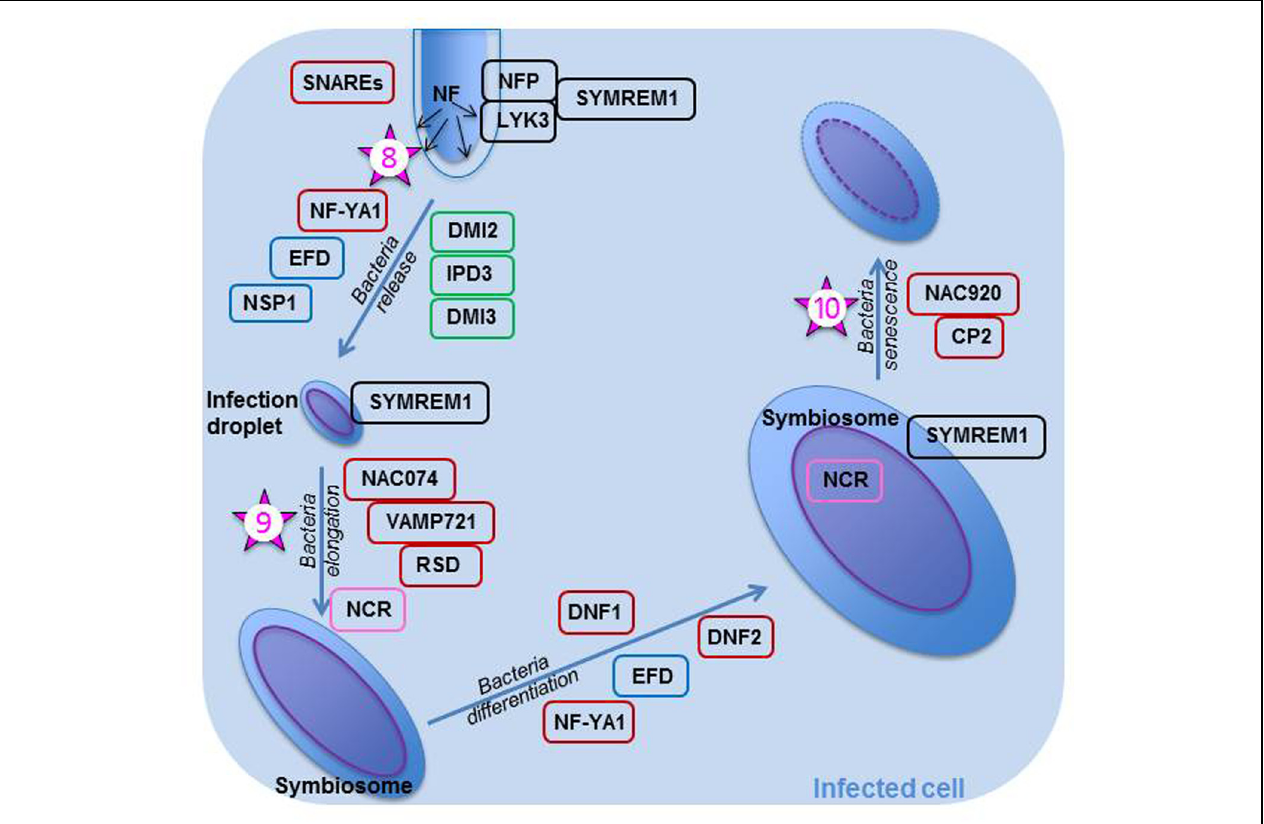
FIGURE 2 | Rhizobial release and bacteroid differentiation within an infected plant cell of Medicago truncatula . Once the rhizobia are released in the infection droplets, they divide and elongate. They later on differentiate into bacteroids; many bacterial genes, such as those necessary for division, are then turned off, whereas genes the products of which are necessary for bacteroid metabolism (nitrogenase, transporters, etc ... ) are turned on. As all these events are important steps in the symbiosis, they are controlled tightly and many genes and their products are implicated in their control. All proteins within a black box are known to be involved with the NF perception. Those in a green box are known to be part of the common symbiotic transduction pathway. Proteins in a blue box are thought to play a role in both the epidermal and cortical nodulation programs. Proteins in a brown box are not known to play a role early in the nodulation process; they may be specific for controlling these specific steps. NFs are continuously produced by rhizobia within the infection thread and when the rhizobia are released, the NFs are perceived by NFP and LYK3, the Nod factor receptors. These receptors are likely to be recruited in a micro-domain by SYMREM1 expressed in the plasmalemma of the infected cell. SNAREs and NF-YA1 are essential in bacterial release, whereas NAC074, VAMP721, and RSD are required for bacterial elongation. The bacteria differentiate once they have perceived the antimicrobial NCRs, which are found in the bacteroid after they crossed both symbiosome and bacterial membranes. DNF1 is necessary for the entry of NCRs in the symbiosome. Bacterial differentiation is also under the control of DNF2. Finally, MtNAC920 working in concert with CP2 trigger bacteroid senescence. The numbered stars represent potential location of ethylene signaling or action and the numbers correspond to the order in which these actions are reported in the